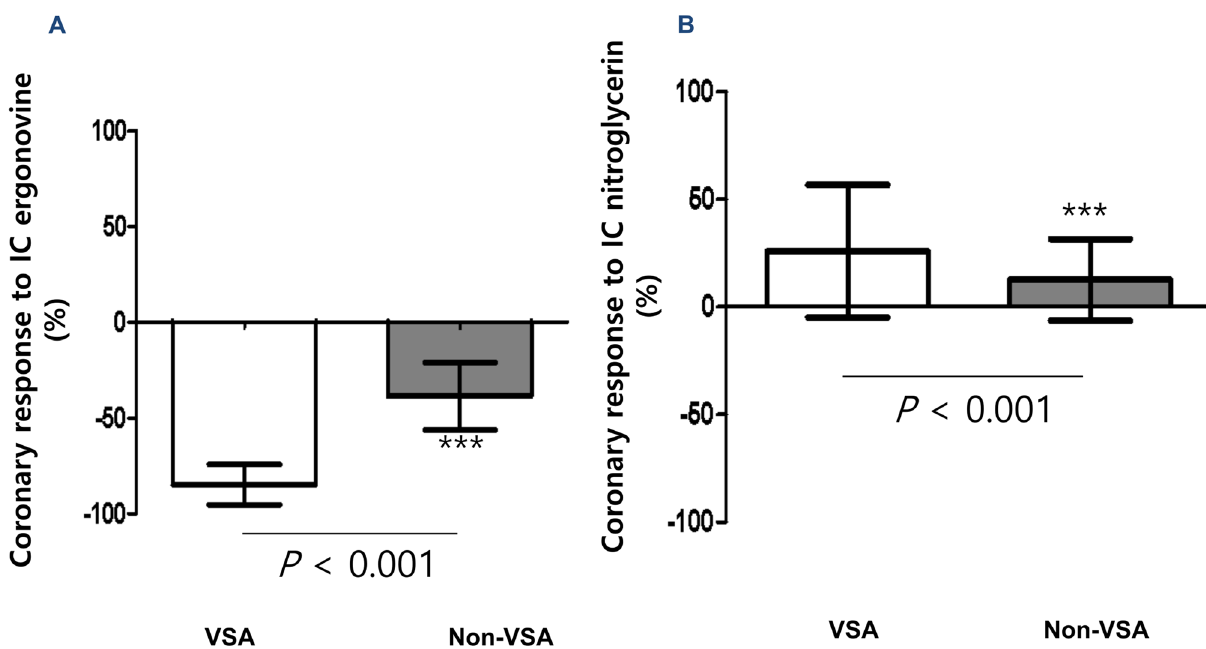
Figure 3. Comparison of coronary response to ergonovine and nitroglycerin between VSA and non-VSA groups. Bars indicate mean, and lines indicate standard deviation of the mean. For comparison of VSA with Non-VSA; p < 0.05*, p < 0.01**, p < 0.001***. Abbreviations: IC intracoronary, VSA vasospastic